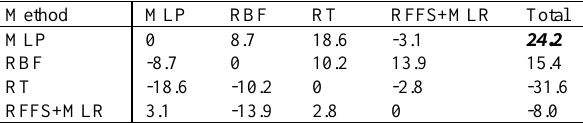
-8.0 Table 1. Scoring matrix results for comparing individual machine learners over the lidar metrics predicted using SPOT-5 textural data in percentage As Table 1 shows for SPOT-5 data, among non-linear